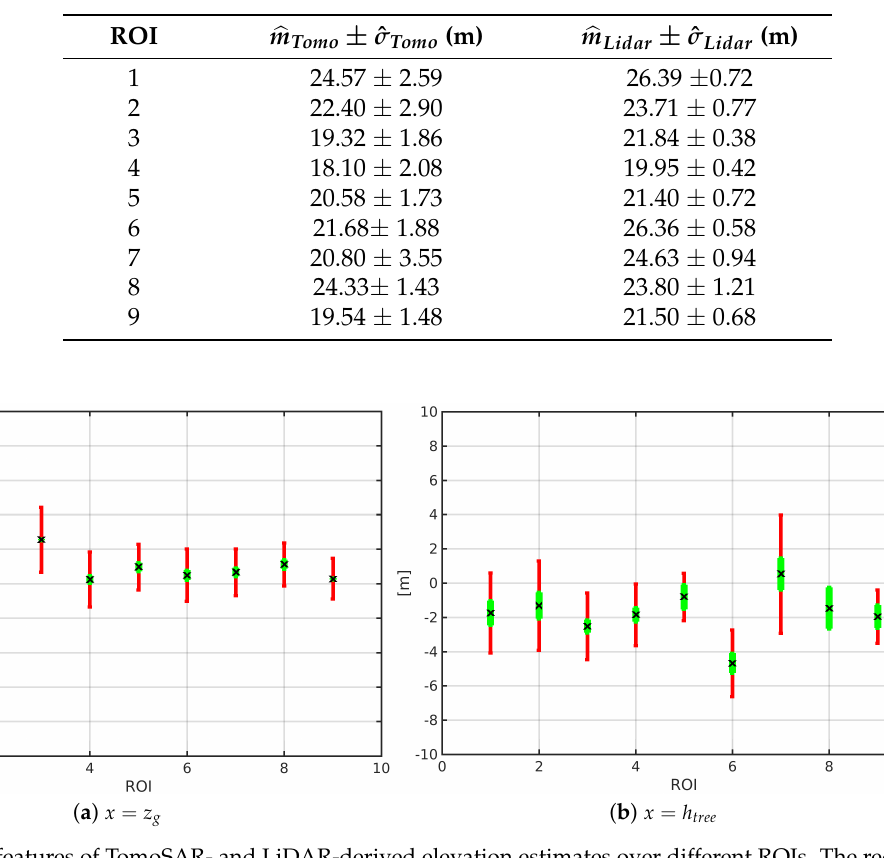
Figure 18. Statistical features of TomoSAR- and LiDAR-derived elevation estimates over different ROIs. The red bar has a length equal to 2ˆ σ ∆ x , the black cross mark indicates (cid:98) m ∆ x and the green bar has a length equal to 2ˆ σ Lidar , i , with i = 1, . . . i i